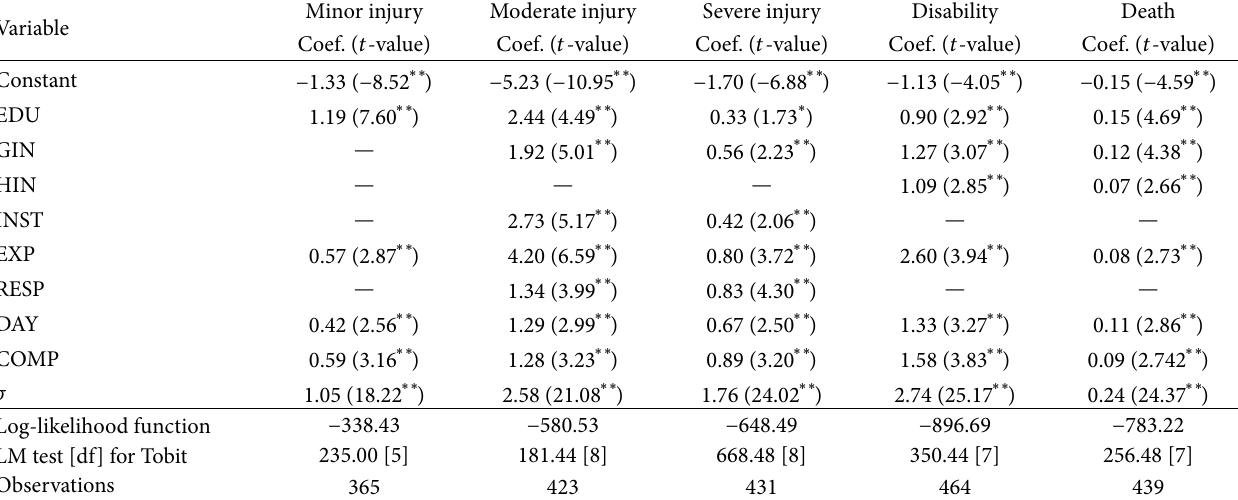
Table 4: Estimation results for WTP for productivity loss (Tobit